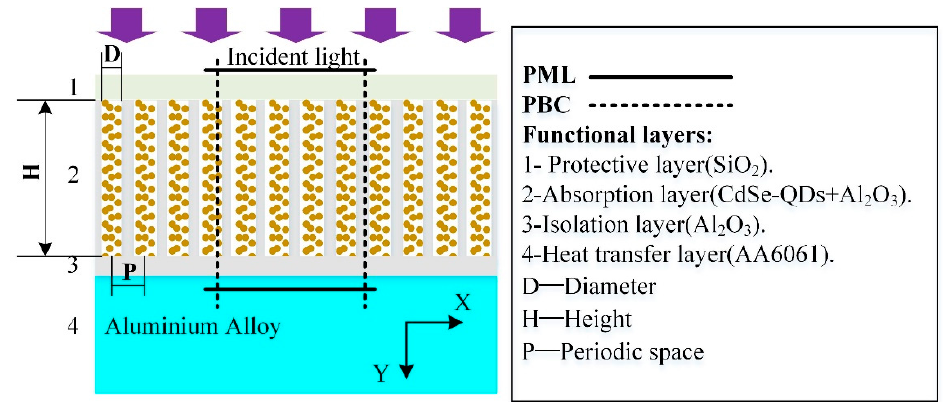
Figure 1. Schematic of simulated anodic aluminum oxide nanopores with embedded CdSe quantum dots.